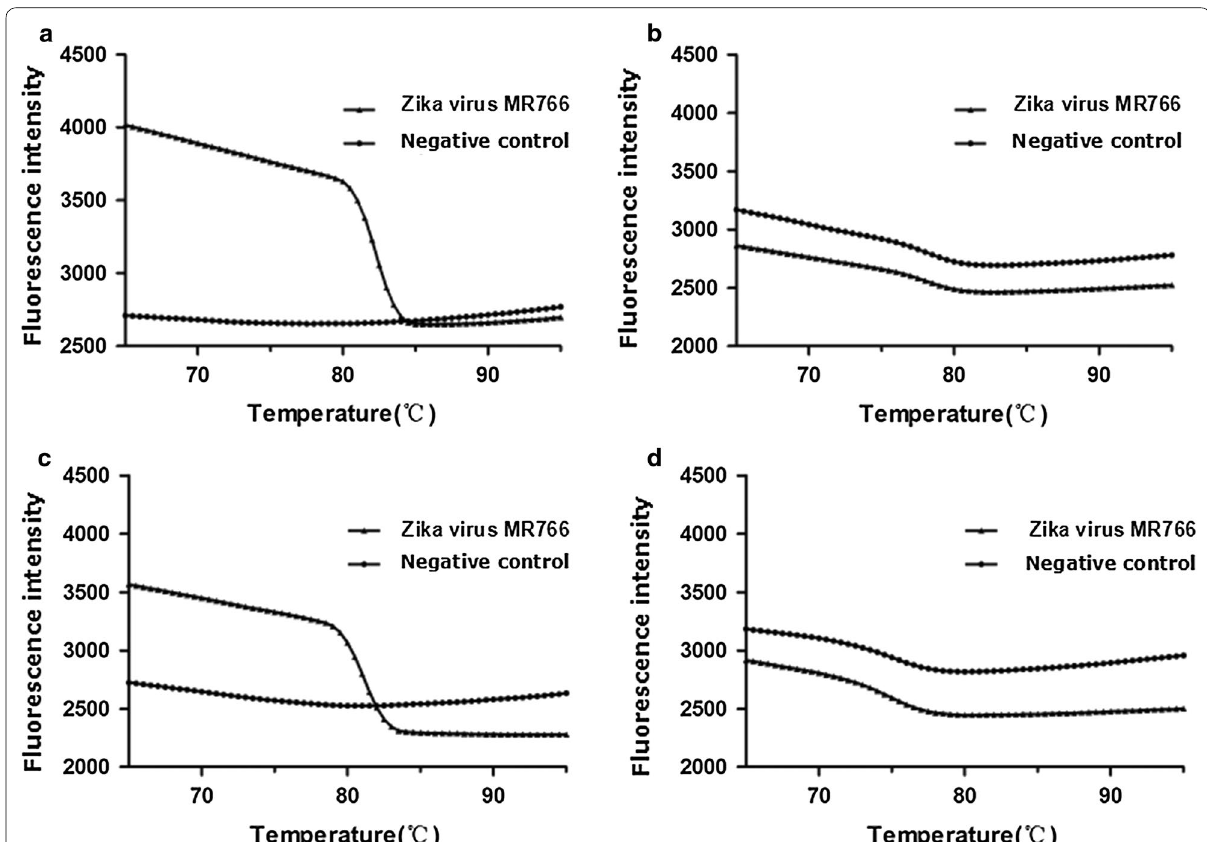
Fig. 4 The LAMP melting curve in this study. a Real‑amp with loop primers (NS5‑1); b real‑amp with loop primers (NS5‑2); c real‑amp with loop primers (NS5‑3); d real‑amp with loop primers (NS5‑4)